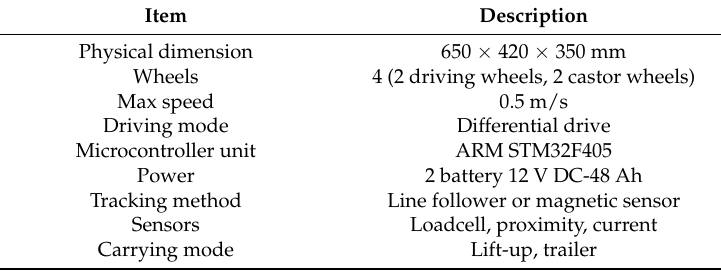
Figure 6. Simulation ( a ) and experiment ( b ) of control board in the project. Table 1. Parameters and specifications of the system.